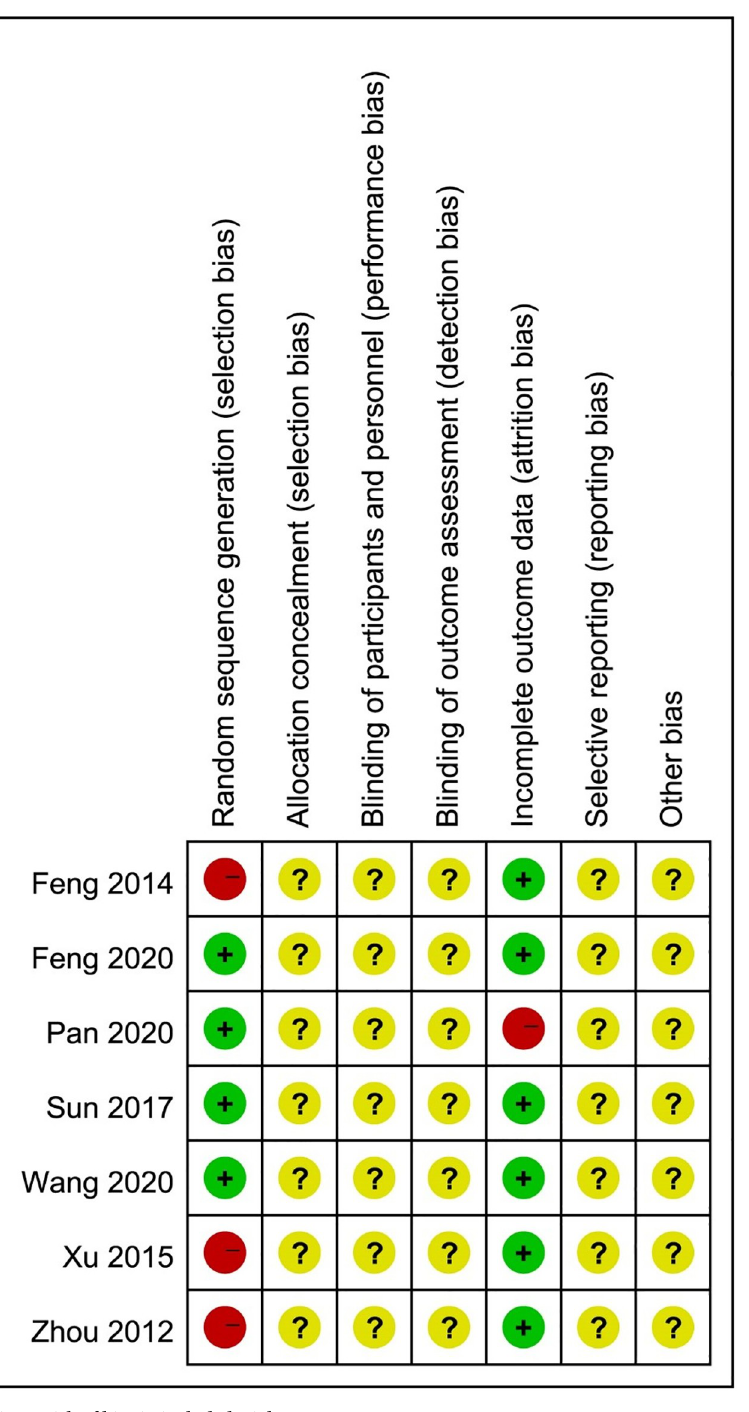
and 6 months ( P = 0.04), CHM and CHM combined with other treatments increased the IGF- 1 level (Fig 10). Subgroup analysis of different comparisons indicated that IGF-1 level in CHM plus other drugs( P = 0.001) and lifestyle intervention ( P = 0.006) was higher than those in